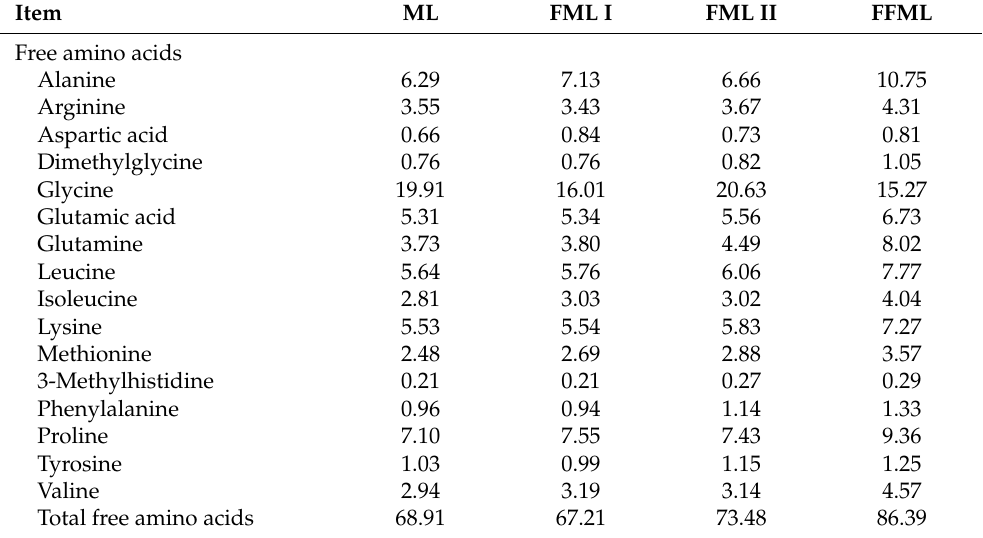
Table 4. Small molecule metabolites composition of Mao-tai lees and fermented Mao-tai lees (mg/kg of